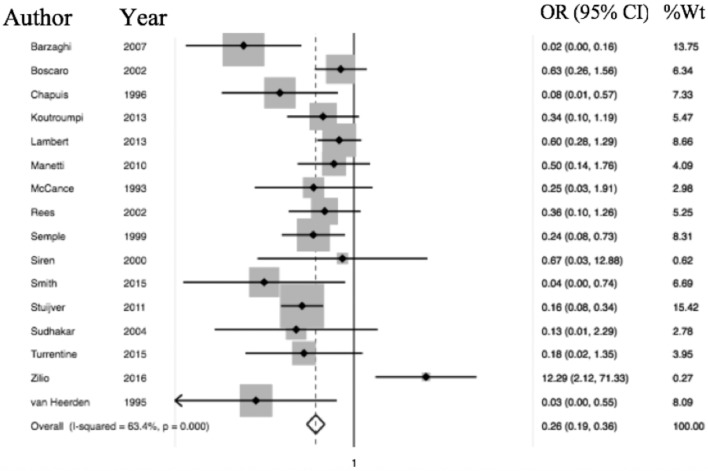
Odds of VTE in CS without anticoagulation significantly less than hip fracture surgery without anticoagulation. Total OR 0.26 (95% CI 0.19–0.36) of postop (within 30 days of surgery) VTE in CS without anticoagulation compared to odds of postoperative VTE in cases of hip fracture repair without anticoagulation. This suggests the odds of VTE in CS patients in the perioperative period for those undergoing adrenalectomy or TSS are 84% less than that of patients undergoing surgery for hip fracture.